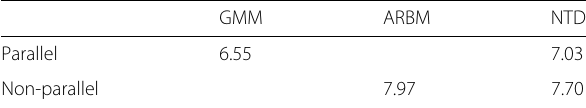
Table 4 Average MCD [dB] on VCC